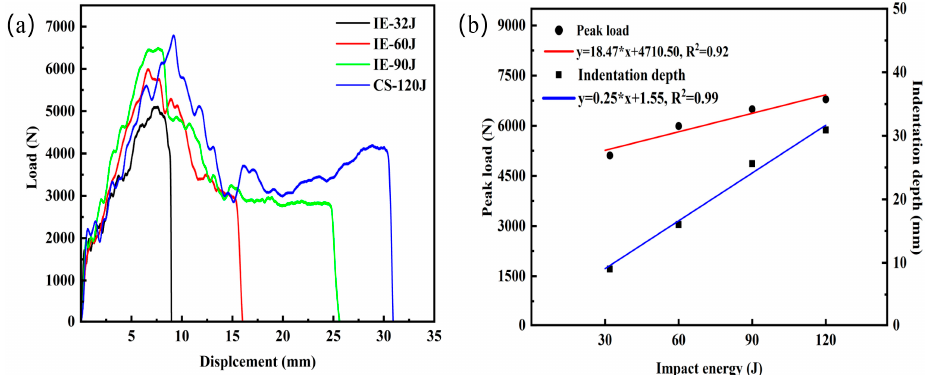
Figure 4. Mechanical response at different impact energy: ( a ) Load-displacement curves; ( b ) Linear fit of peak load and the indentation depth at different energy.